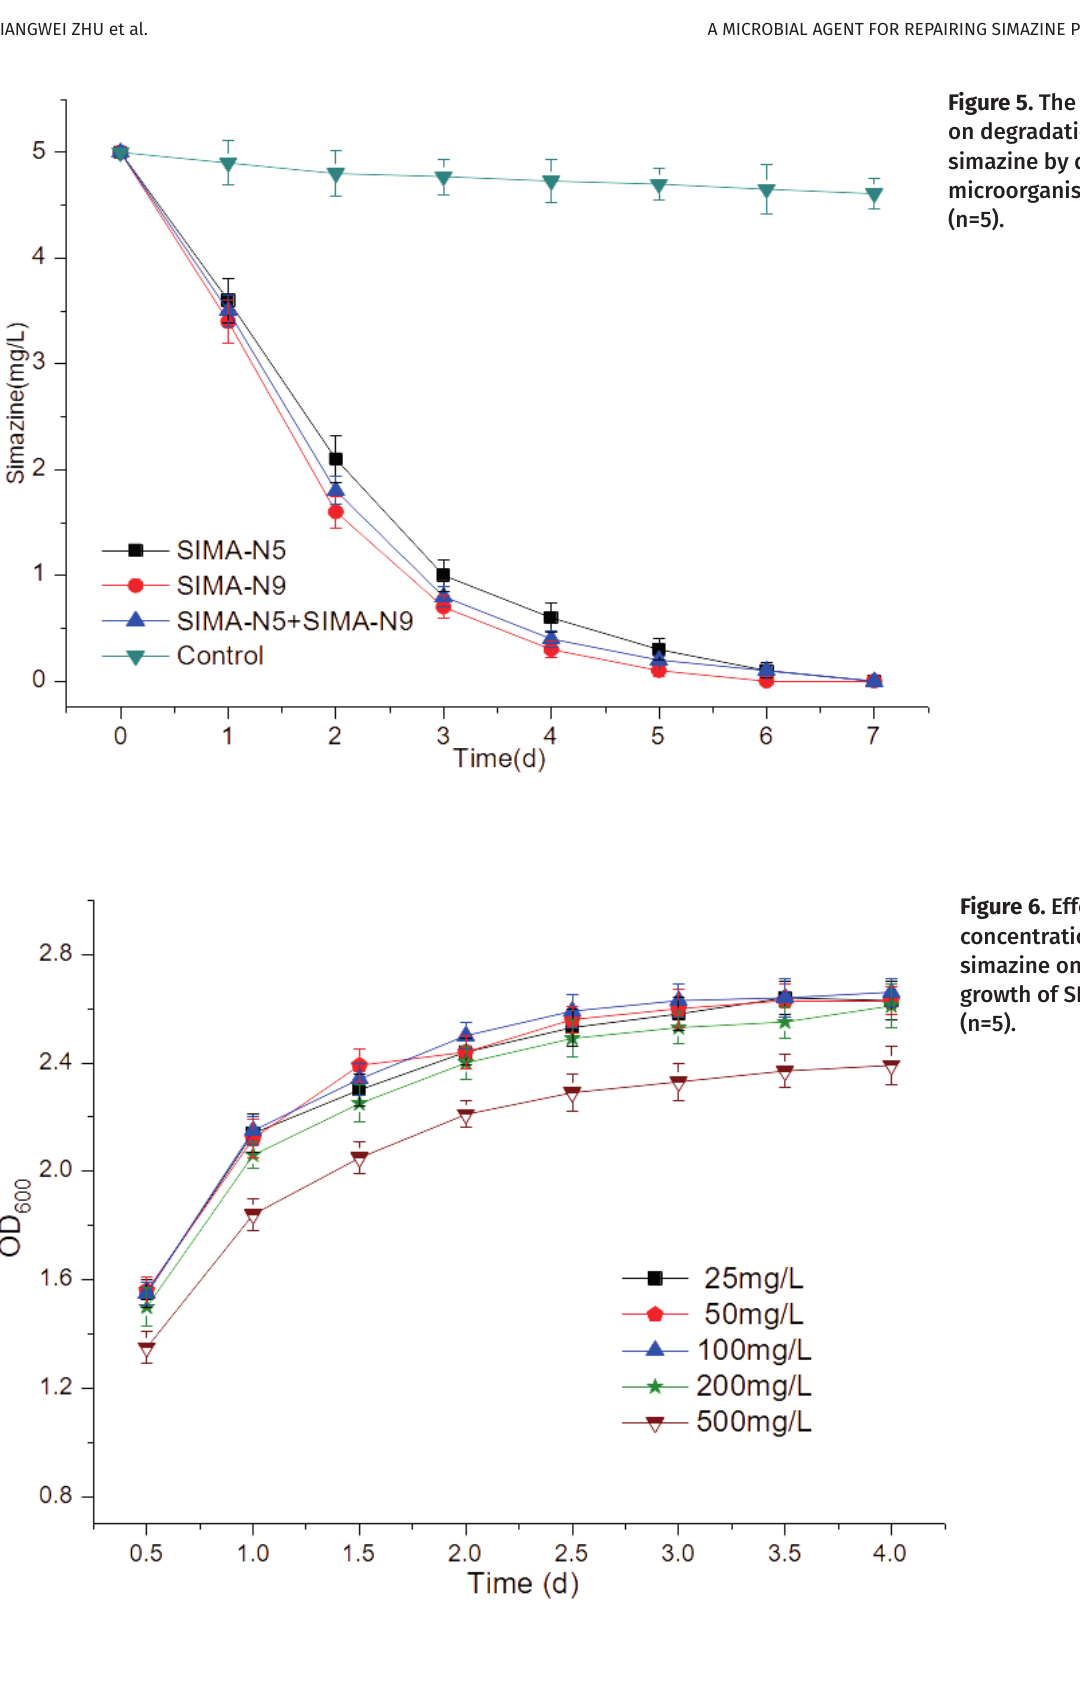
Figure 6. Effect of concentration of simazine on the growth of SIMA-N5